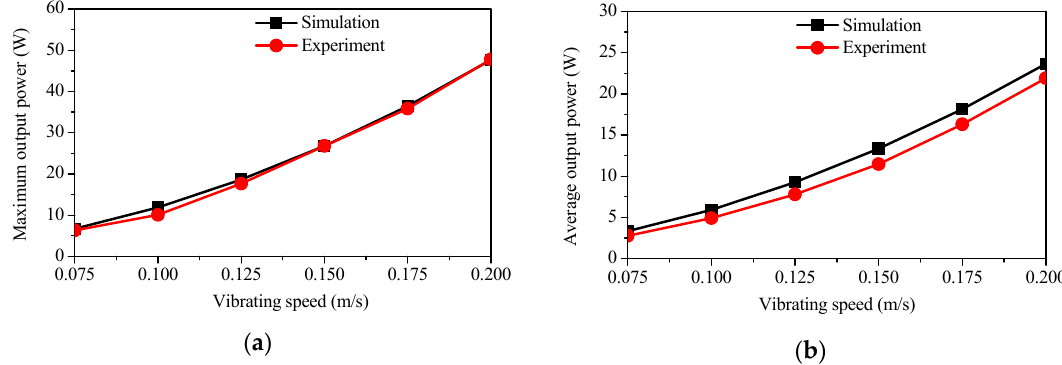
Figure 7. Power variation according to vibrating speeds under full load condition: ( a ) maximum output power; ( b ) average output power.